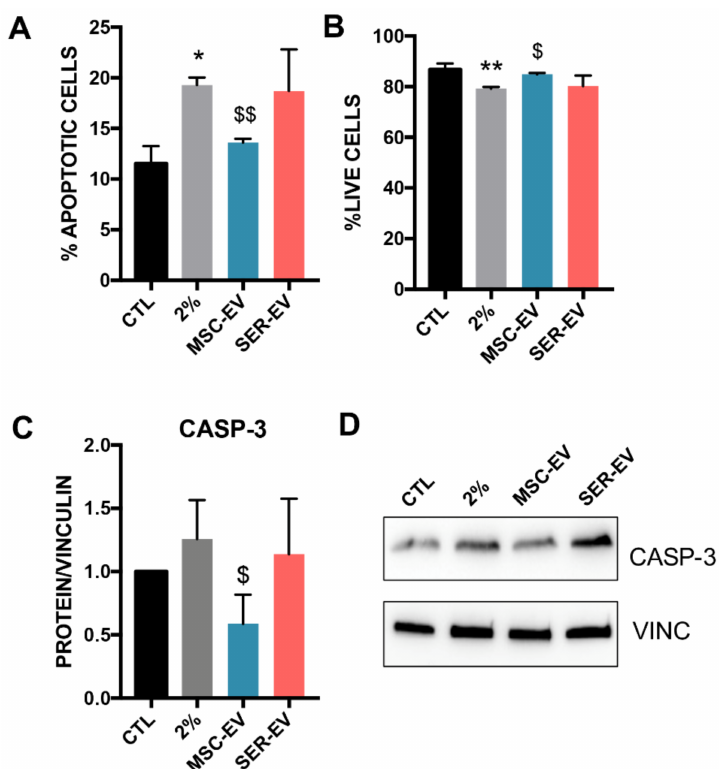
Figure 6. Apoptosis regulation HCECs after serum deprivation and EV treatment. HCECs were exposed to serum starvation for 24 h and further stimulated with MSC- or SER-EVs for 24 h. ( A ) Percentage of total apoptotic HCECs cultured either in normal conditions (CTL) or in serum depri- vation for 24 h (2%), and treated for further 24 h with MSC-EVs or SER-EVs (20 × 10 3 EV/cell). ( B ) Percentage of total live HCECs cultured either in normal conditions (CTL) or in serum deprivation for 24 h (2%), and treated for a further 24 h with MSC-EVs or SER-EVs (20 × 10 3 EV/cell). ( C ) Protein levels of caspase-3 (CASP-3) and its quantification normalized to total vinculin (VINC). Vinculin was used as the endogenous control. CTL, set as 1, was used as the reference sample for each experiment. The graphs show the average of at least three independent experiments ± SD. One-way ANOVA with Tukey’s multiple comparisons test was performed after the normalization of each experiment to CTL. * p < 0.05 vs. CTL, ** p <0.001 vs. CTL, $ p < 0.05 vs. 2%, $$ p < 0.001 vs. 2%. ( D ) Representative image of Western blots on HCECs blotted with caspase-3 and the endogenous control